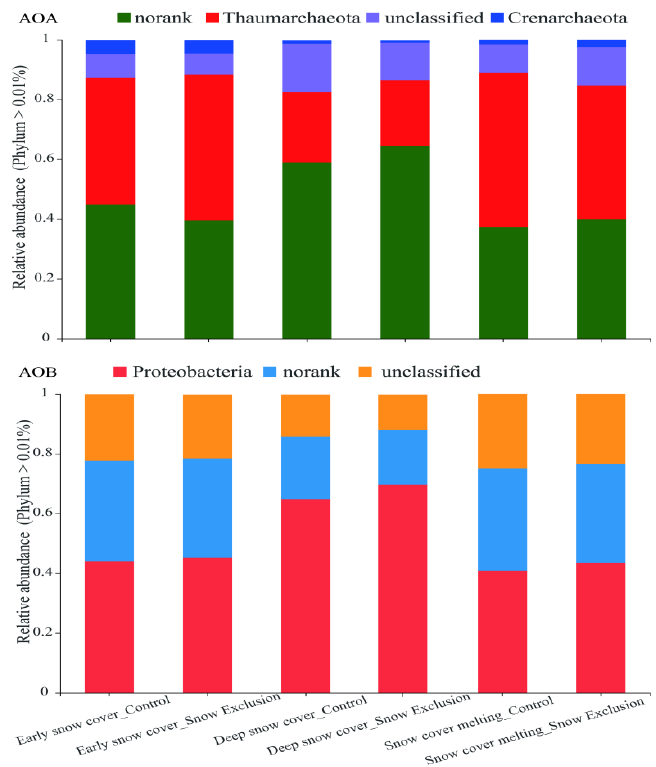
Figure 3. Relative abundance of different AOA and AOB phyla in the control and snow exclusion plots during the winter.